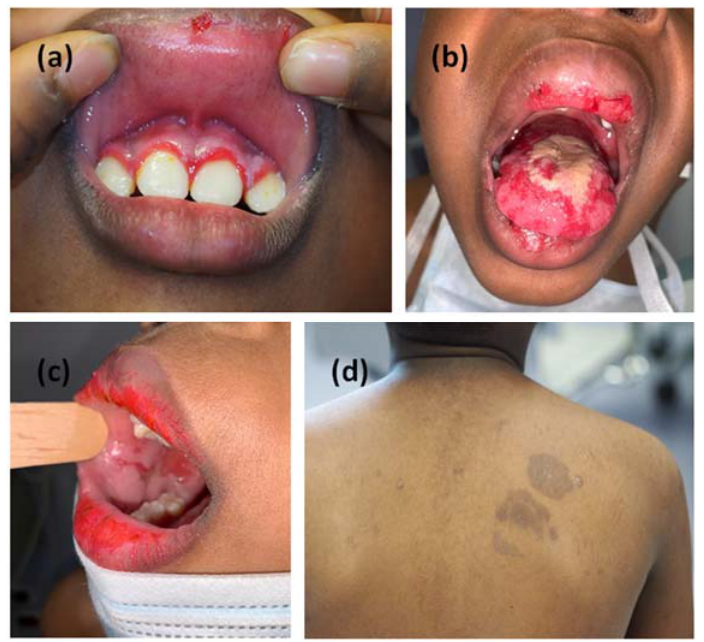
Figure 1. Clinical manifestation with erosive lesions of the oral cavity symmetrically distributed to gum ( a ), tongue ( b ) and mucous membrane of the cheeks ( c ). Hyperpigmented lesions on the skin arose six months later ( d ).